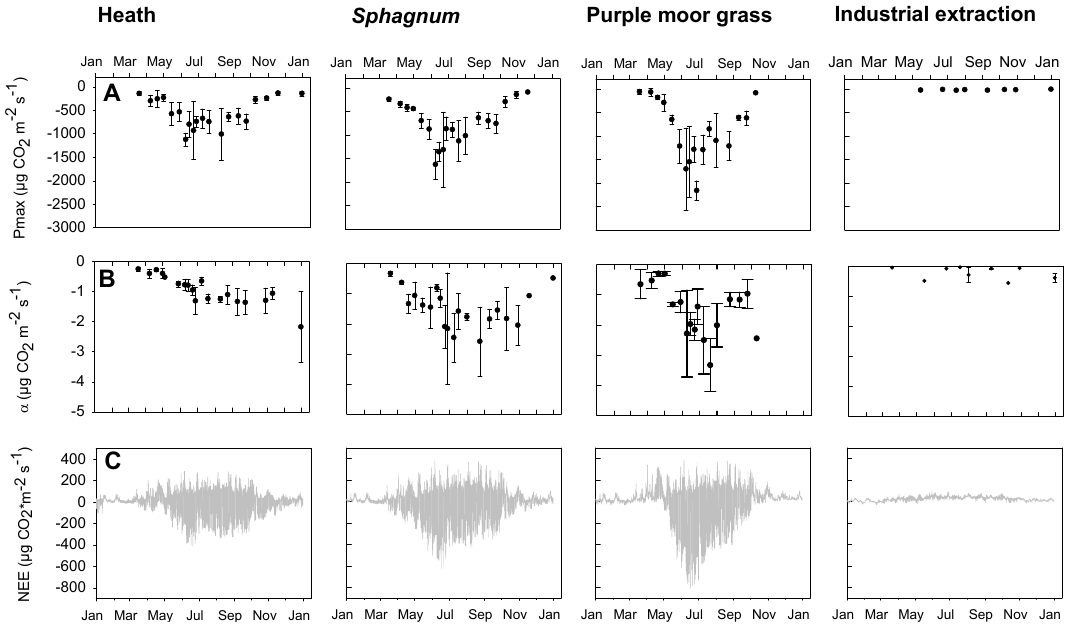
Figure 3. Model parameters for gross primary production (GPP 1 model) in 2011: (a) maximum photosynthetic activity ( P max ) and (b) values for the initial light response efficiency ( α) . Points indicate means of four replicate plots ± SD. (c) Mean modeled net ecosystem exchange (NEE) in 2011. Positive values represent emissions and negative values uptakes.